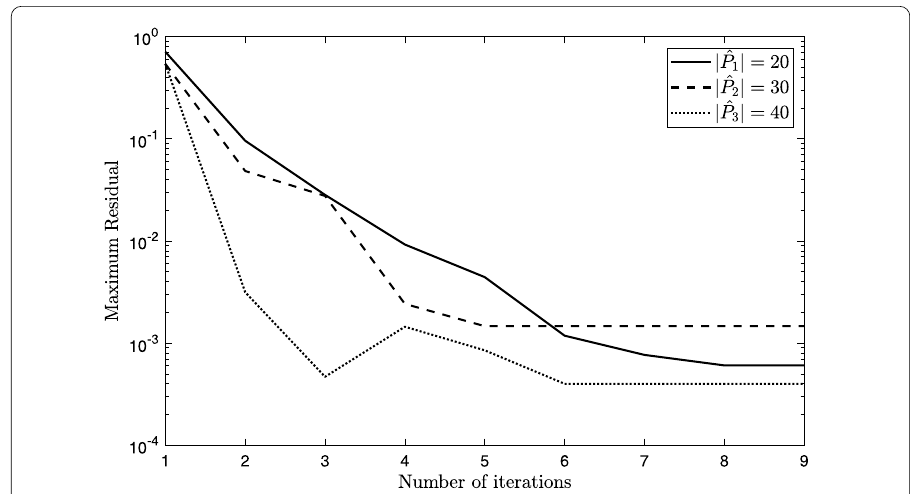
Figure 5 Evolution of the maximum residual error for three different cardinalities of set ˆ P